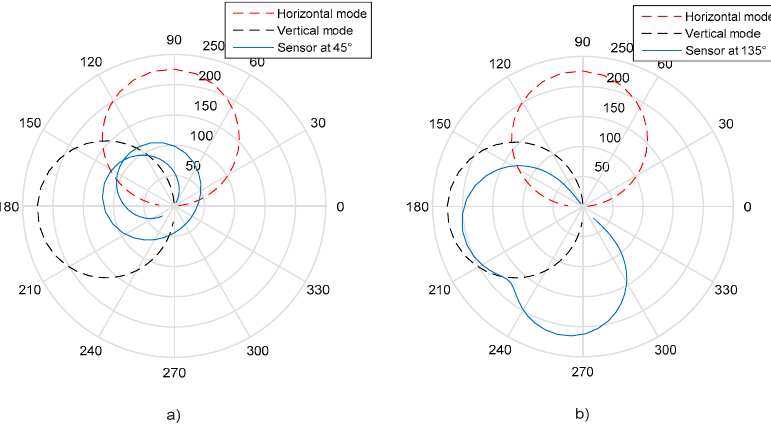
Figure 4. Coupling of 2 DOF vibration modes for a sensor position at ( a ) 45° and ( b ) 135°.